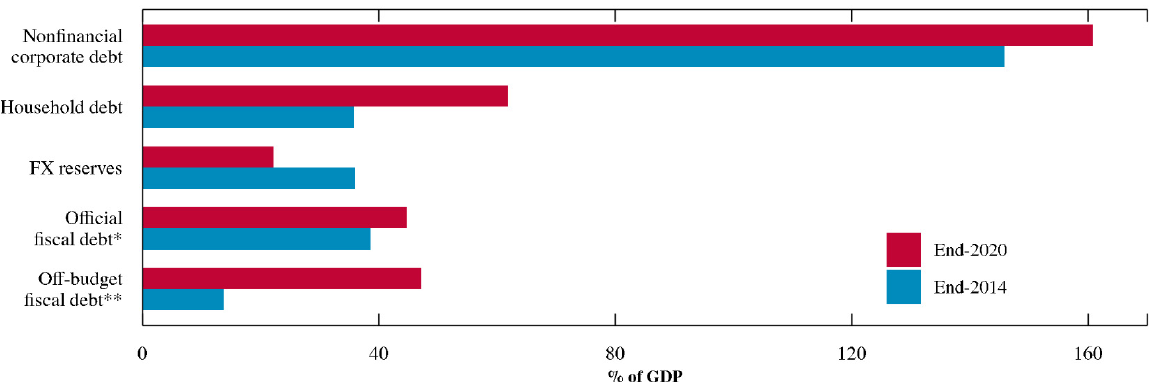
Figure 1. Financial vulnerabilities. * This narrow definition of government debt includes central government debt and explicit local government debt recognized in the national audit in 2015 but does not include off-budget borrowing after 2015. ** Off-budget fiscal debt includes local government financing vehicles and other off-budget activity. The sum of this item and recognized fiscal debt equals IMF’s definition of augmented fiscal debt. Sources: People’s Bank of China, National Bureau of Statistics, Bank for International Settlements, and IMF’s Financial Sector Assessment Program.